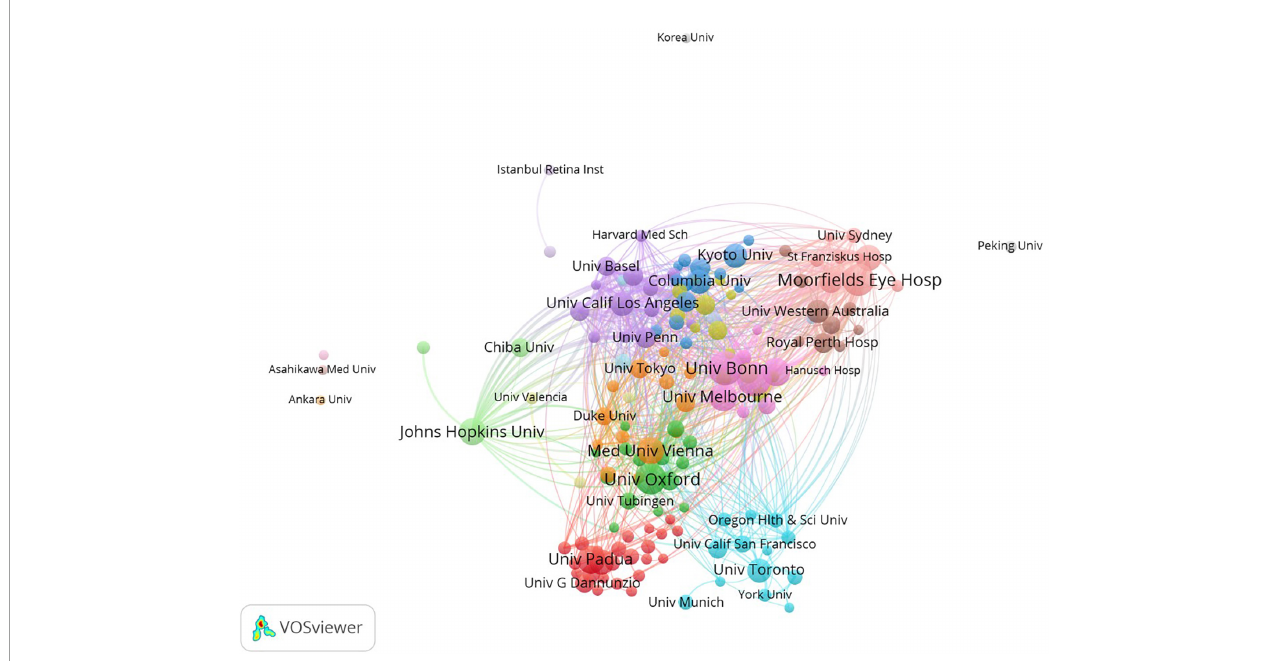
FIGURE7 The co-authorship of institutions. The size of nodes demonstrated the number of publications by institutions. The curves between the nodes illustrated their co-operation. The shorter the distance between two nodes showed the closeness of co-operation between the two institutions.